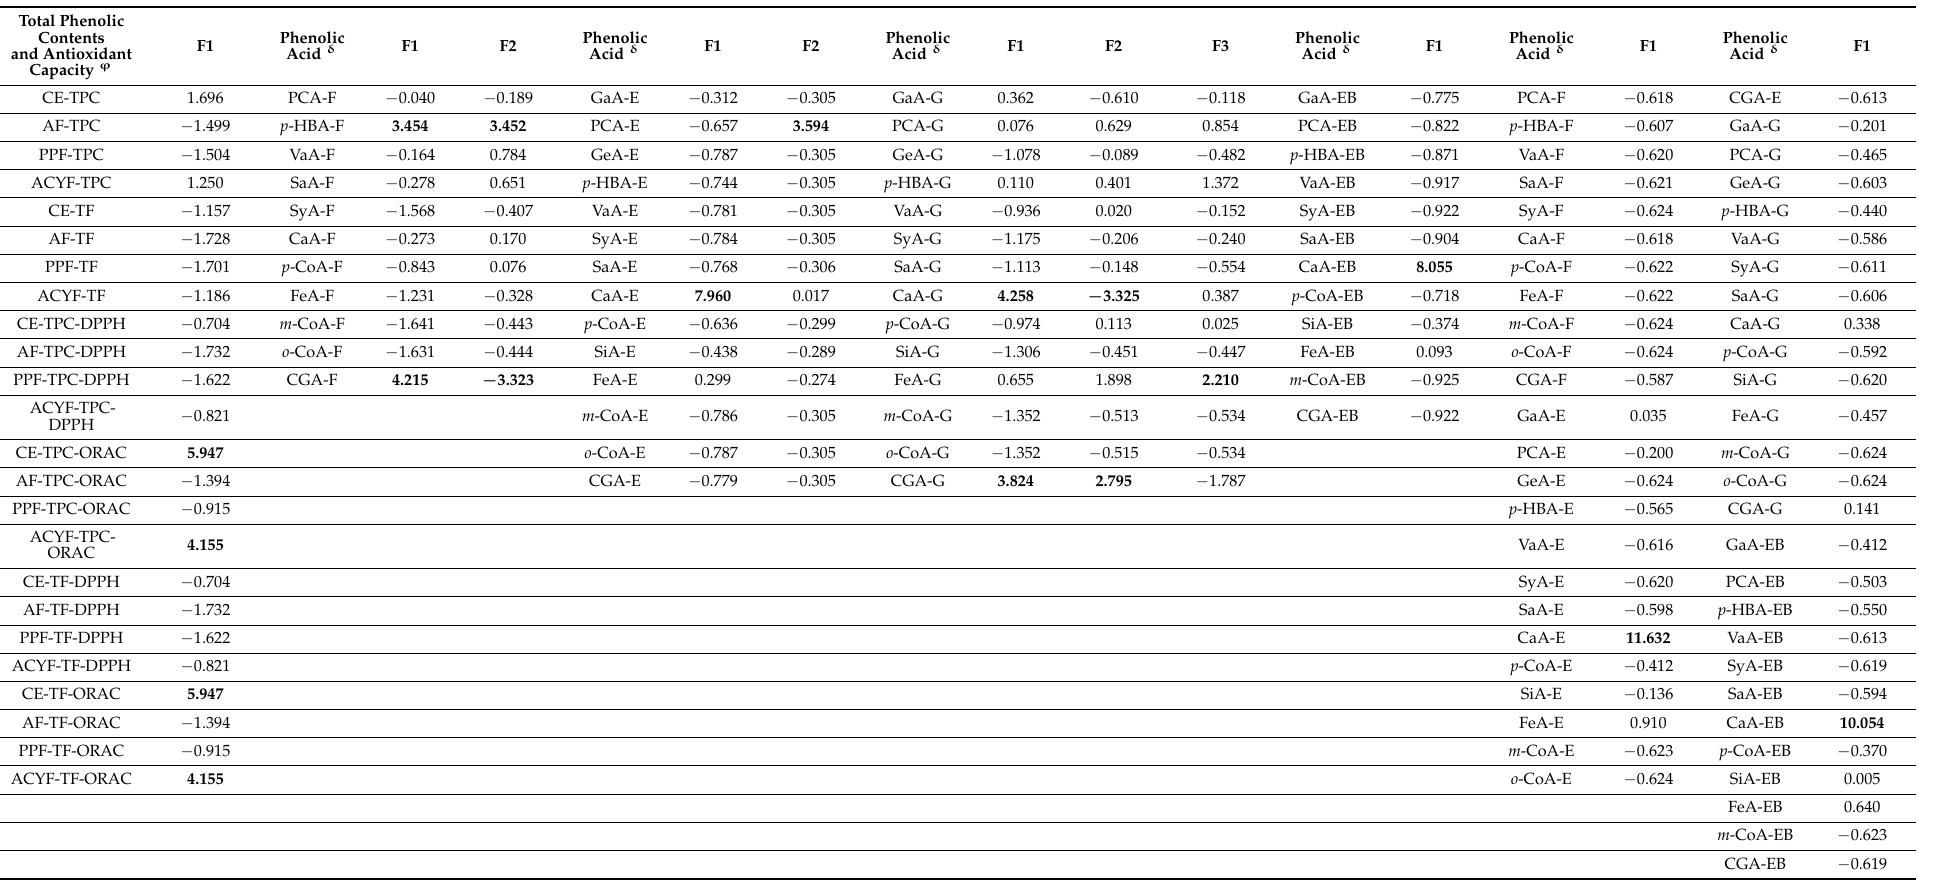
Table 5. Factor (F) scores of total phenolic contents, antioxidant capacity values, and phenolic acids obtained from the principal component analysis (PCA) comparing the peel and pulp in